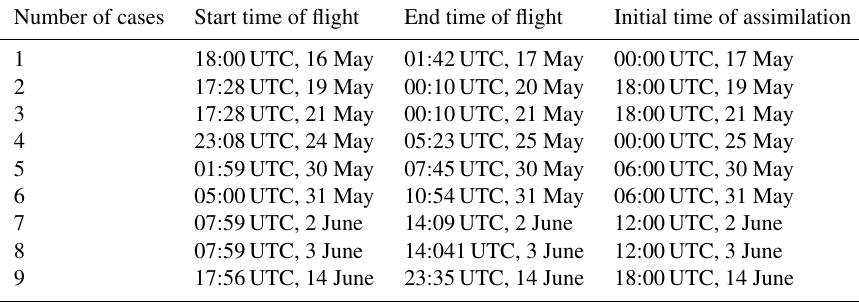
Table 2. The periods of flight during CalNex 2010 and the initial time of